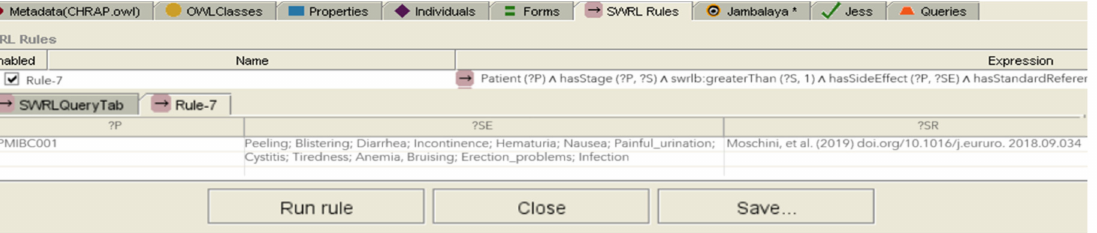
Figure 8. Model-based SQWRL results displayed in Prot é g é .